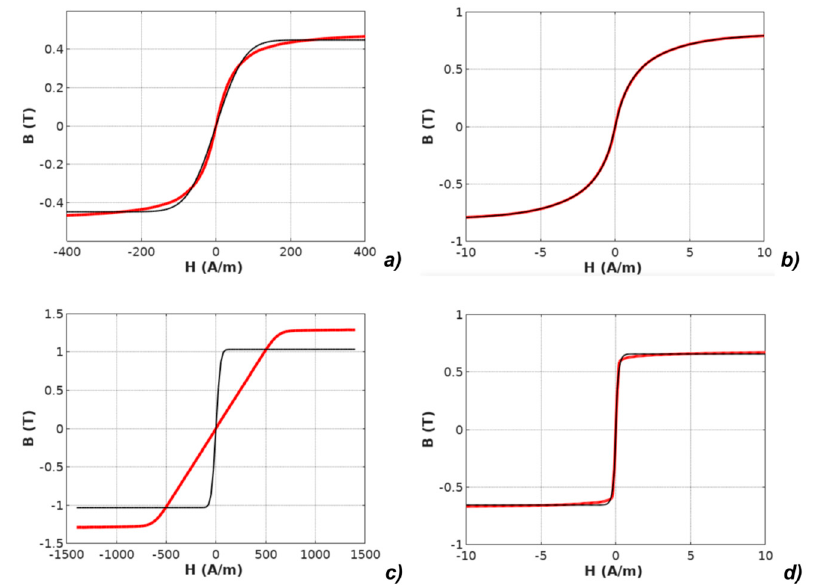
Figure 3. Results of modeling the anhysteretic curve using the erf-based function (measurements: red line, modeling: black line): ( a ) Mn-Zn ferrite F3001, ( b ) Co 67 Fe 4 Mo 1 B 11 Si 17 amorphous alloy, ( c ) Fe 73.5 Cu 1 Nb 3 Si 15.5 B 7 nanocrystalline alloy with perpendicular anisotropy, ( d ) Fe 67 Co 18 B 14 Si 1 amorphous alloy with parallel anisotropy.